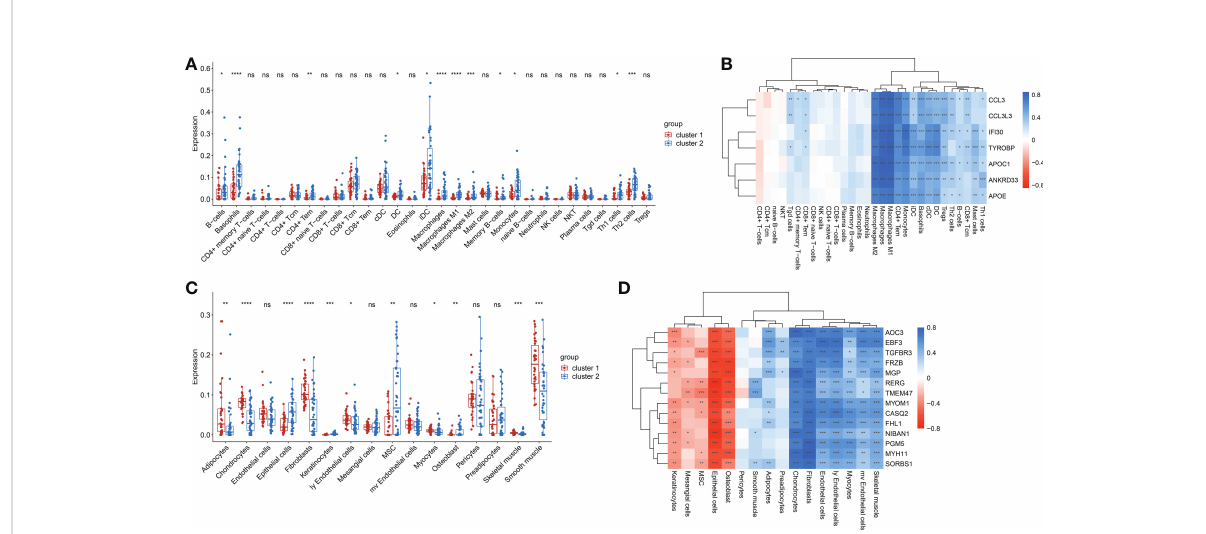
FIGURE 5 The abundances of immune cells and stroma cells in cluste1 and cluster2. (A) . Comparison of the immune cell abundances in cluster 1 and cluster2. (B) . Correlation of the immune cell abundances and the expression of immune-related genes. (C) . The comparison of the stroma cells abundances in cluster 1 and cluster2. (D) . Correlation of the stroma cells abundances and the expression of stroma score-related genes. (*p<0.05; **p<0.01; ***p<0.001; ****p<0.0001; ns, no signi fi